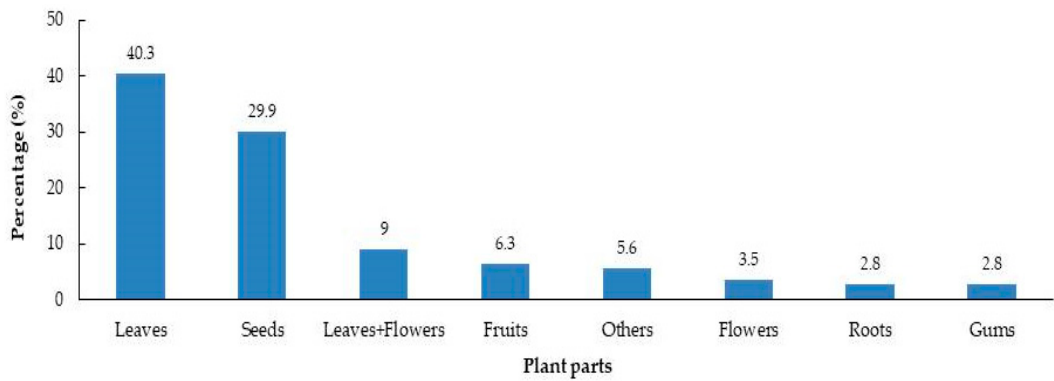
Figure 3. Diversity in plant parts of the evaluated species.